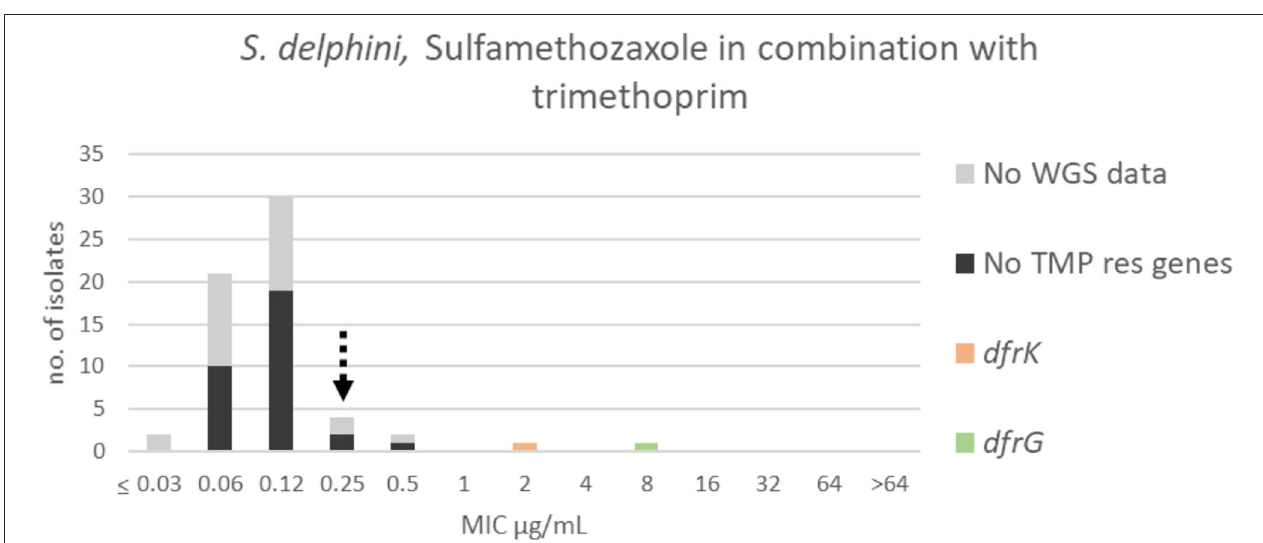
FIGURE 13 | MIC distribution of Staphylococcus delphini ( n = 61) against sulfamethoxazole in combination with trimethoprim (19:1) in the test range of 0.03–64 µ g/mL. The broken arrow indicates the tentative epidemiological cut-off value (TECOFF). Colors indicate if the isolates have been sequenced and whether they harbor known relevant resistance genes. WGS, whole-genome sequencing; res, resistance.